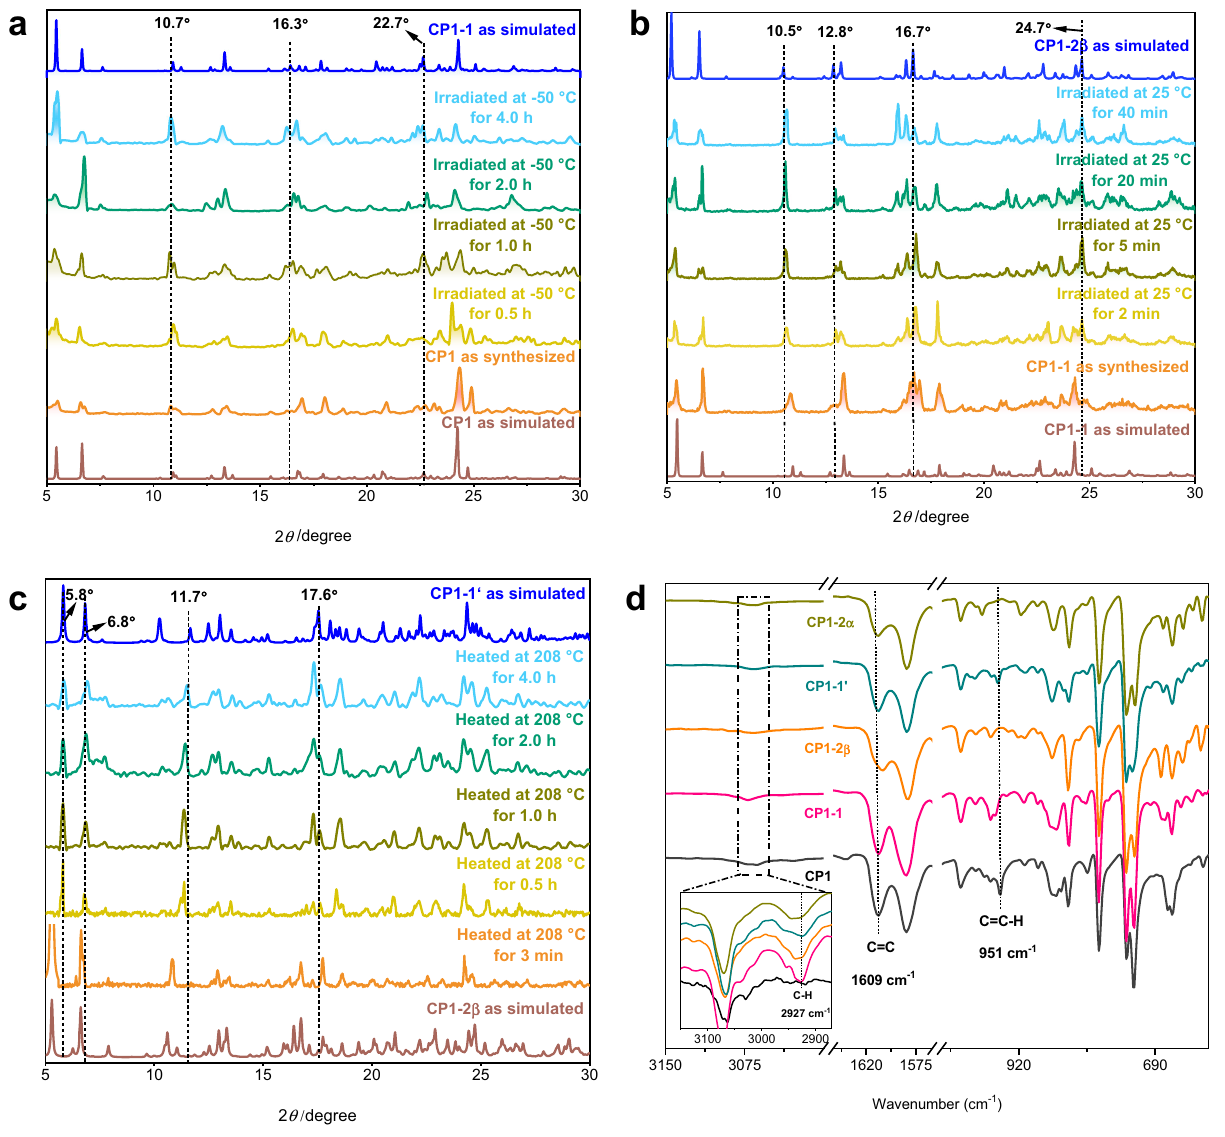
Fig. 3 In-situ characterization. a The in-situ PXRD patterns of the samples of CP1 irradiated by UV light at − 50 °C within different irradiation time intervals. b The in-situ PXRD patterns of the samples of CP1 - 1 irradiated by UV light at 25 °C within different irradiation time intervals. c The in-situ PXRD patterns of the samples of CP1 - 2 β heated at 208 °C within different time intervals. d FT-IR spectra of CP1 , CP1 - 1 , CP1 - 2 β , CP1 - 1 ′ , and CP1 - 2 α